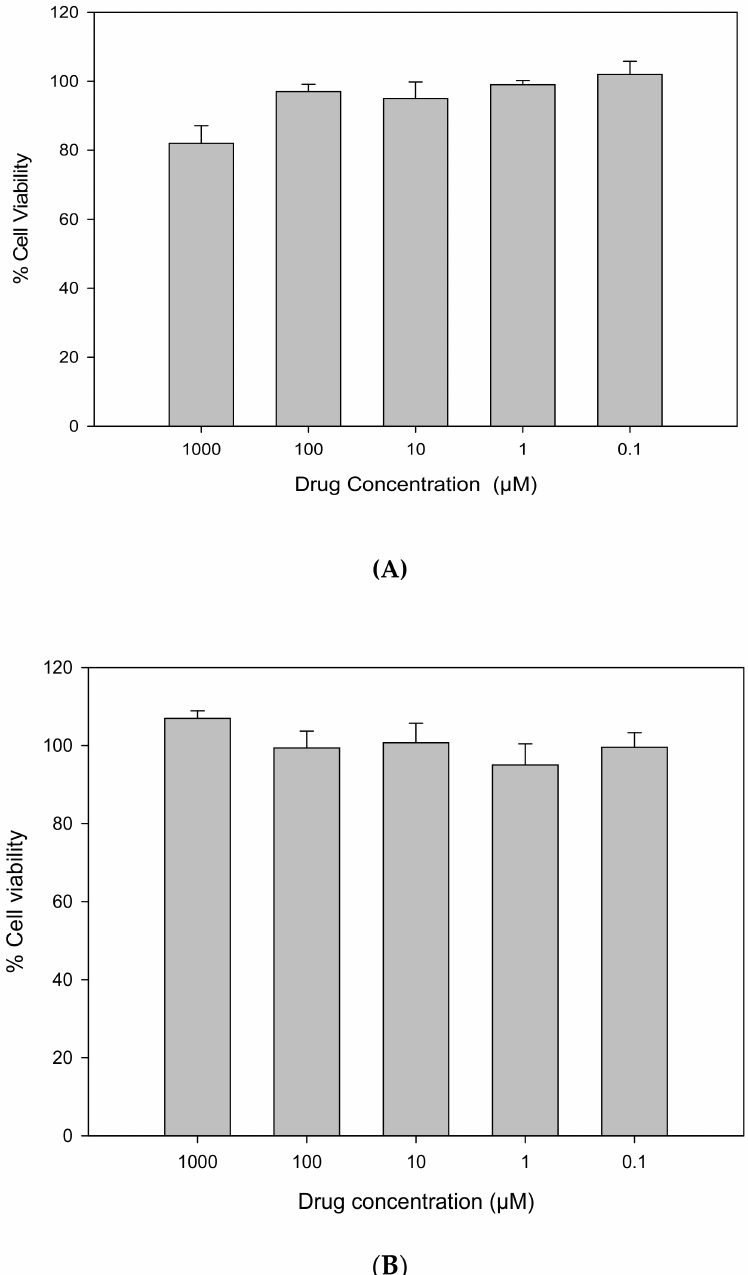
Figure 6. In vitro cell viability of raw resatorvid on ( A ) human transformed keratinocytes (HaCaT) and ( B ) primary normal human epidermal keratinocytes